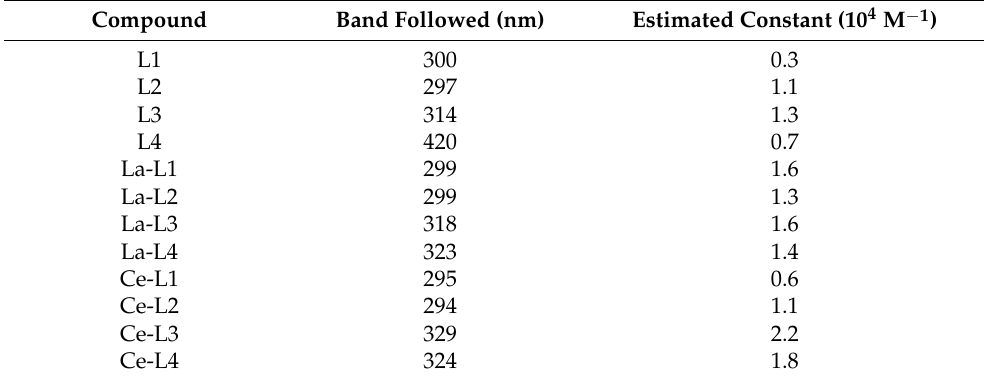
Table 4. Intrinsic binding constants (Kb) for all compounds